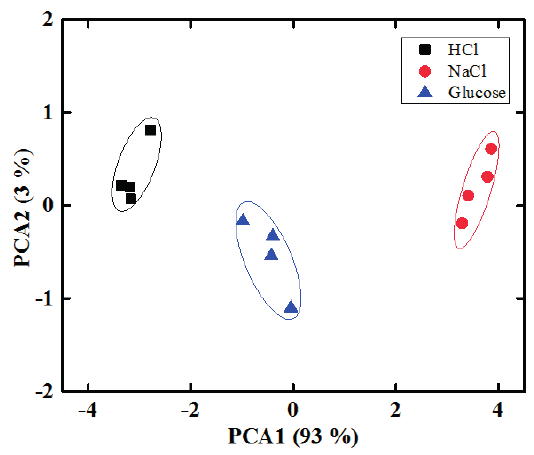
Figure 13. PCA plots of the response to the three different tastes.